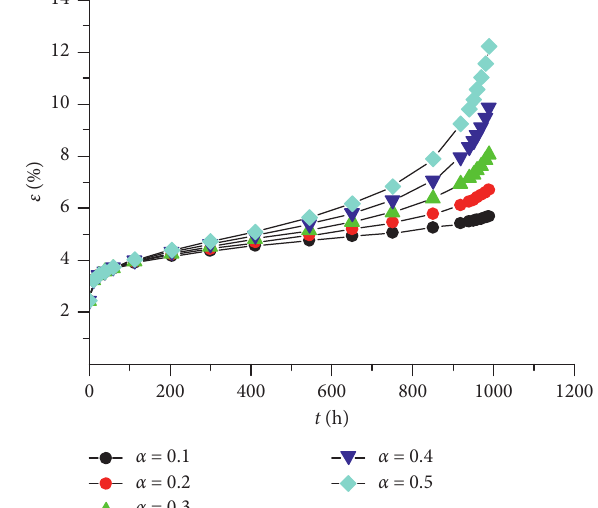
Figure 7: Sensitivity of the creep strain to exponent α ( σ � 14.41MPa, σ s � 13.5MPa, E � 0.590GPa, ξ � 3.662GPa · h β , t F � 1056h, and β �